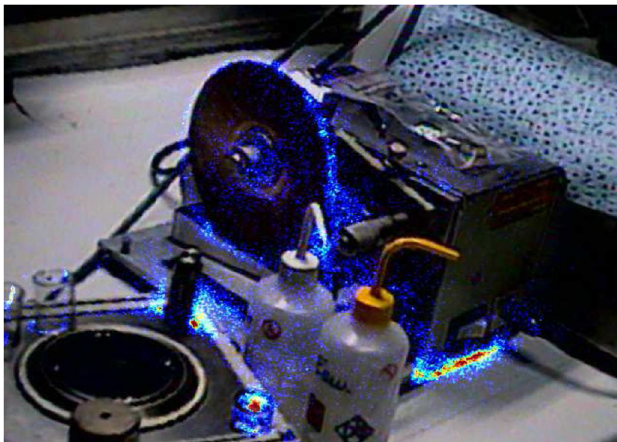
Fig. 2. Localization by means of an alpha camera of plutonium contamination inside a glove box of the ATALANTE facility at the CEA